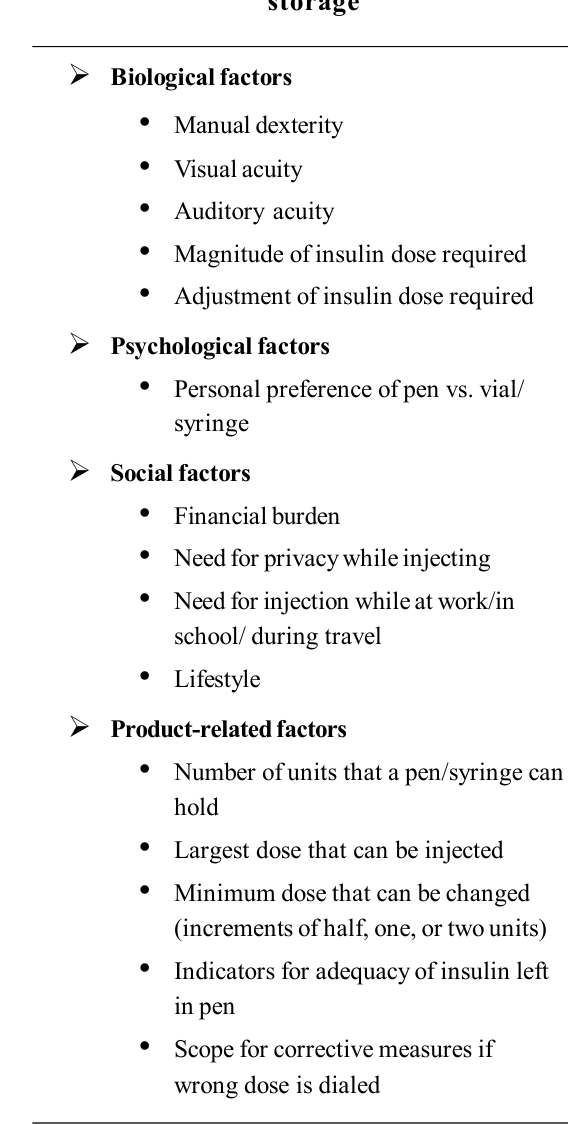
Table 3. Alternative methods of